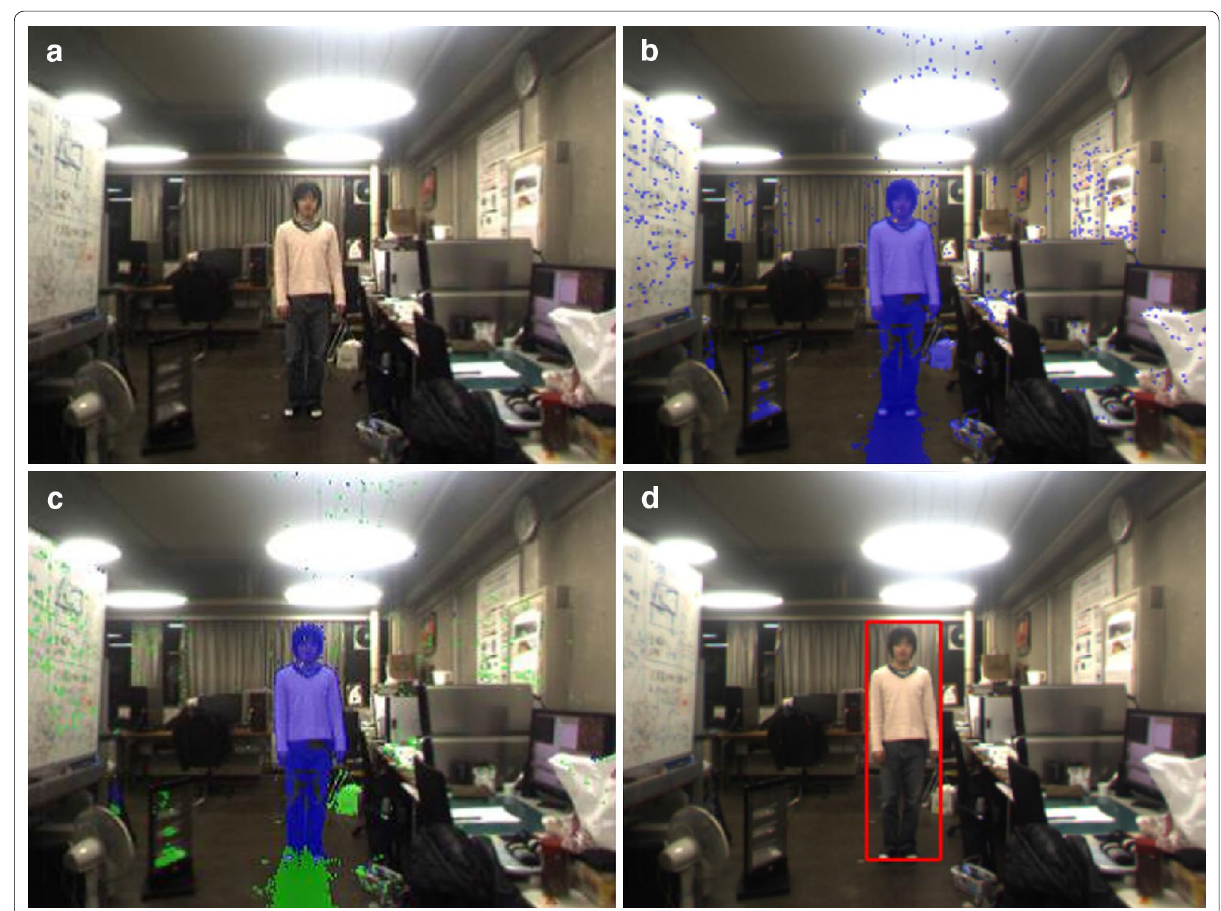
Fig. 2 Procedure of subtraction stereo. a Input image, b subtraction stereo, c Shadow removal, d foreground